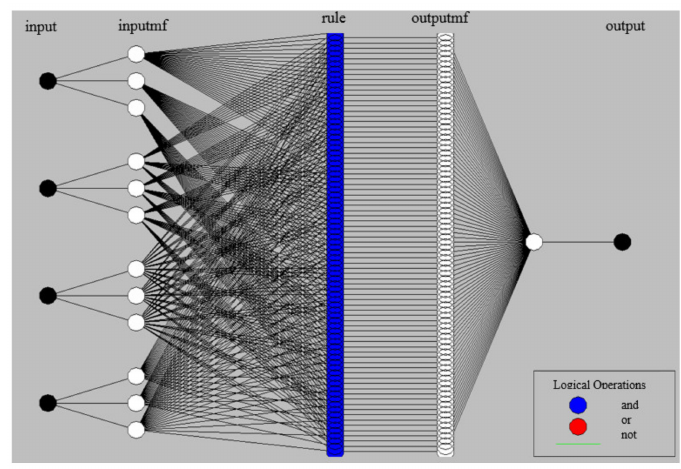
Figure 9. View of the developed fuzzy model.